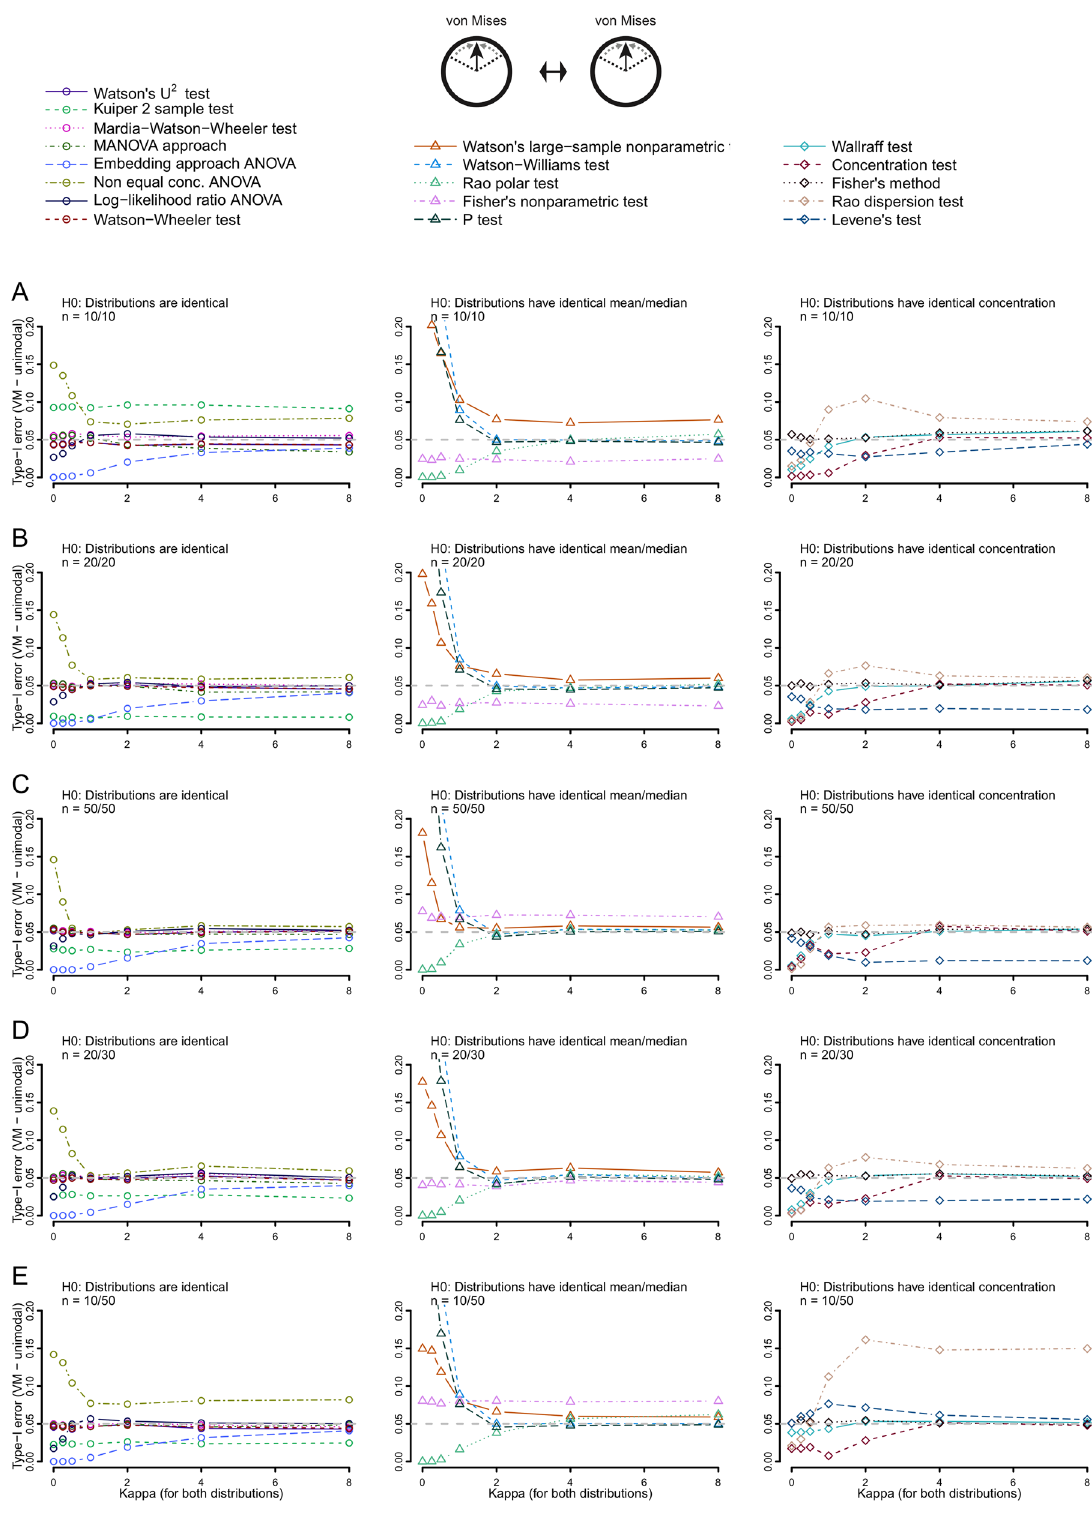
Figure 2. Type-I error of all tests using von Mises distributions for different sample sizes: 10 and 10 ( A ), 20 and 20 ( B ), 50 and 50 ( C ), 20 and 30 ( D ) and 10 and 50 ( E ). Concentration (κ, kappa) increases for both distributions from 0 to 8. Tests are grouped according to their null